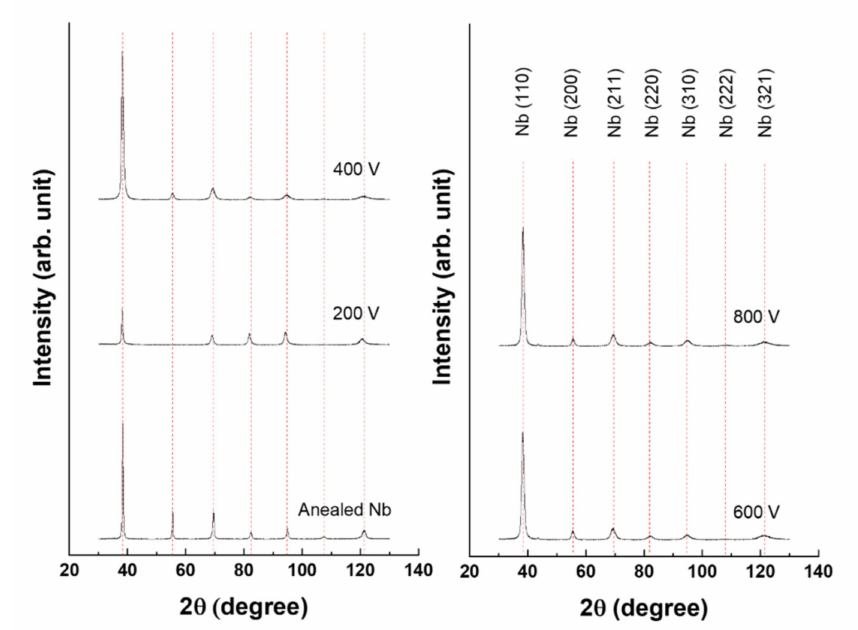
Figure 5. XRD patterns of Nb-coated 316L at the various